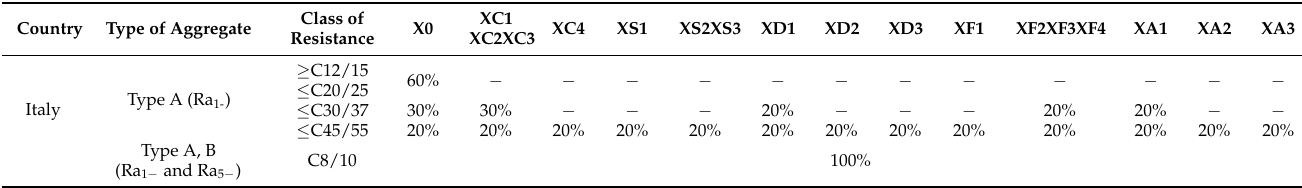
Table 8. Maximum percentage of substitution in Italy (UNI